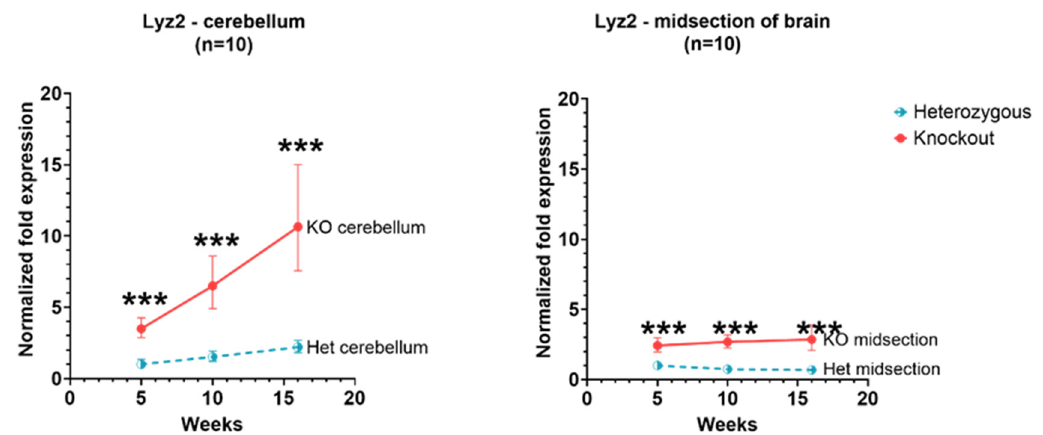
Figure 3. Relative Lyz2 expression in the cerebellum and cerebral cortex of Hexb-KO Sandhoff disease mouse model (***— p value < 0.001; midsection of brain represents cerebral cortex).